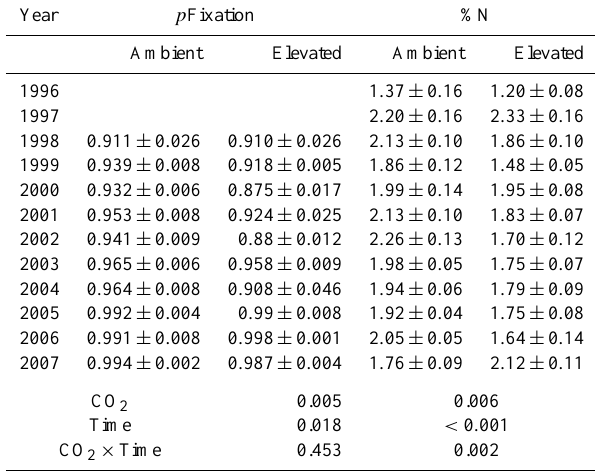
Table 1. Proportion of N derived from fixation and N concentration in Galactia elliottii during 11 years of exposure to elevated CO 2 and results from repeated measures ANOVAs for effects of time, elevated CO 2 , and their